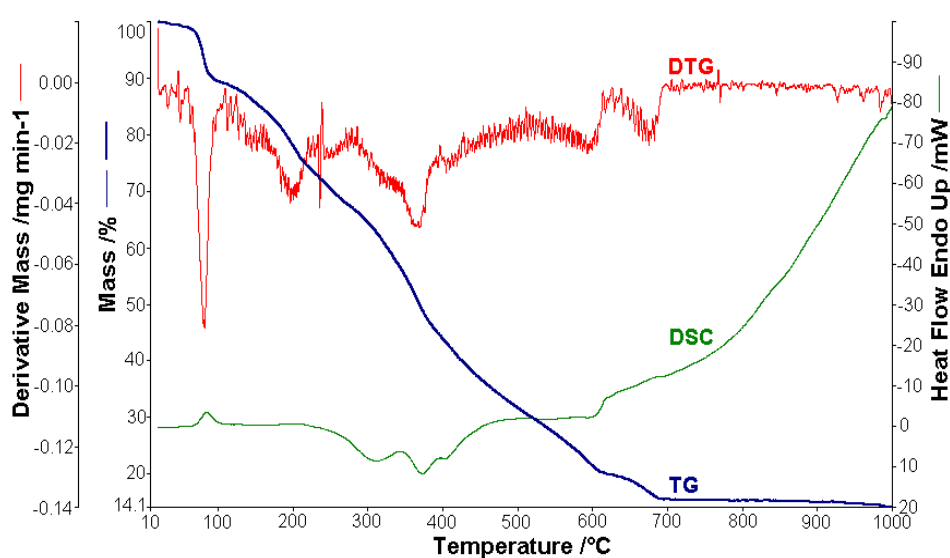
Figure 6. Thermoanalytical curves of [CuL 2 ] ∙ 4.5H 2 O.